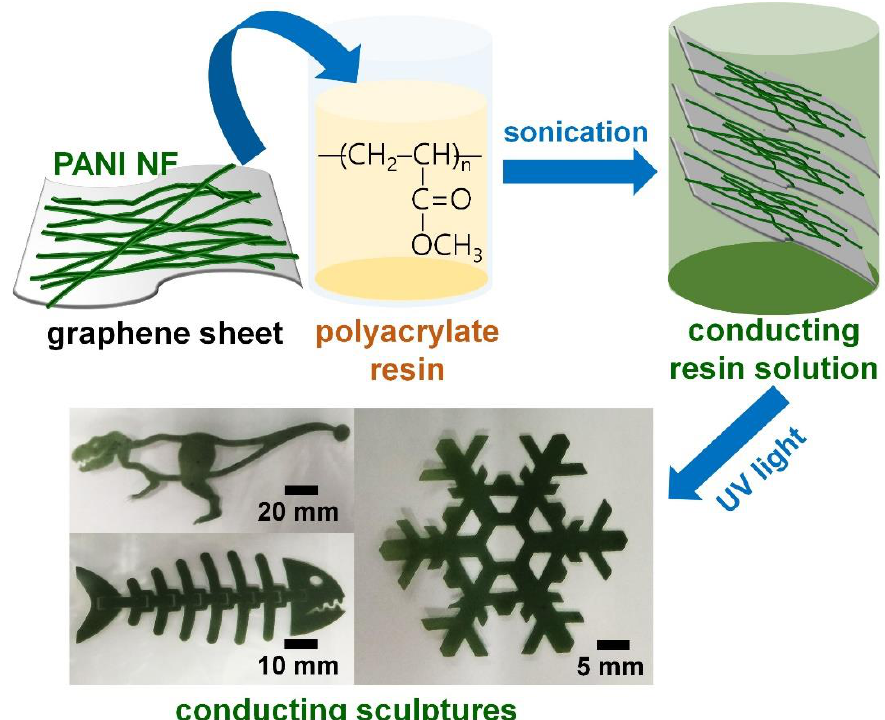
Figure 1. Overall process of conductive 3D printing using polyacrylate resin solution employing PANI NF (polyaniline nanofibers) and graphene sheet.